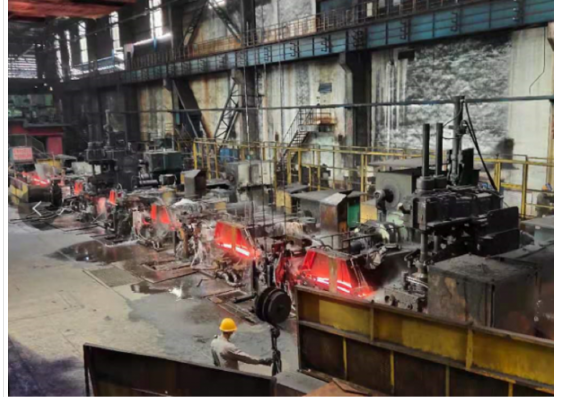
Figure 5. Photo of medium finishing